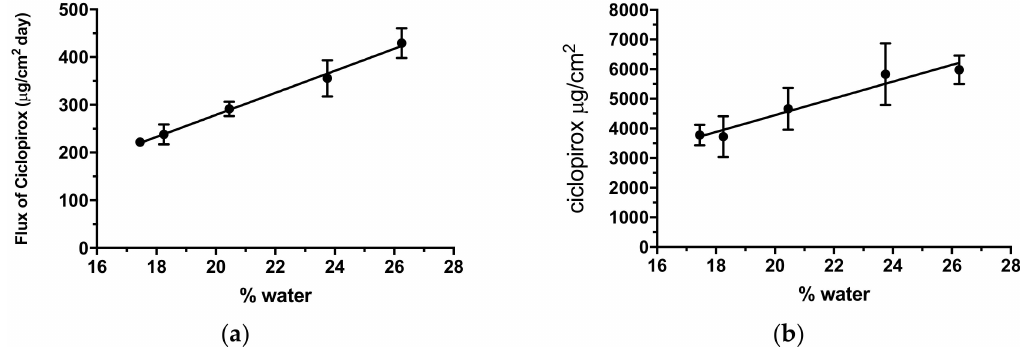
Figure 4. Relationship between ciclopirox flux from day 1 to day 11 ( a ) and the total amount of ciclopirox base di ff used by the end of day 11 ( b ) according to the proportion of water in the